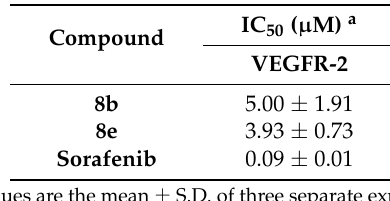
Table 4. IC 50 values for the inhibitory activity of pyridine-urea 8e and 8n against